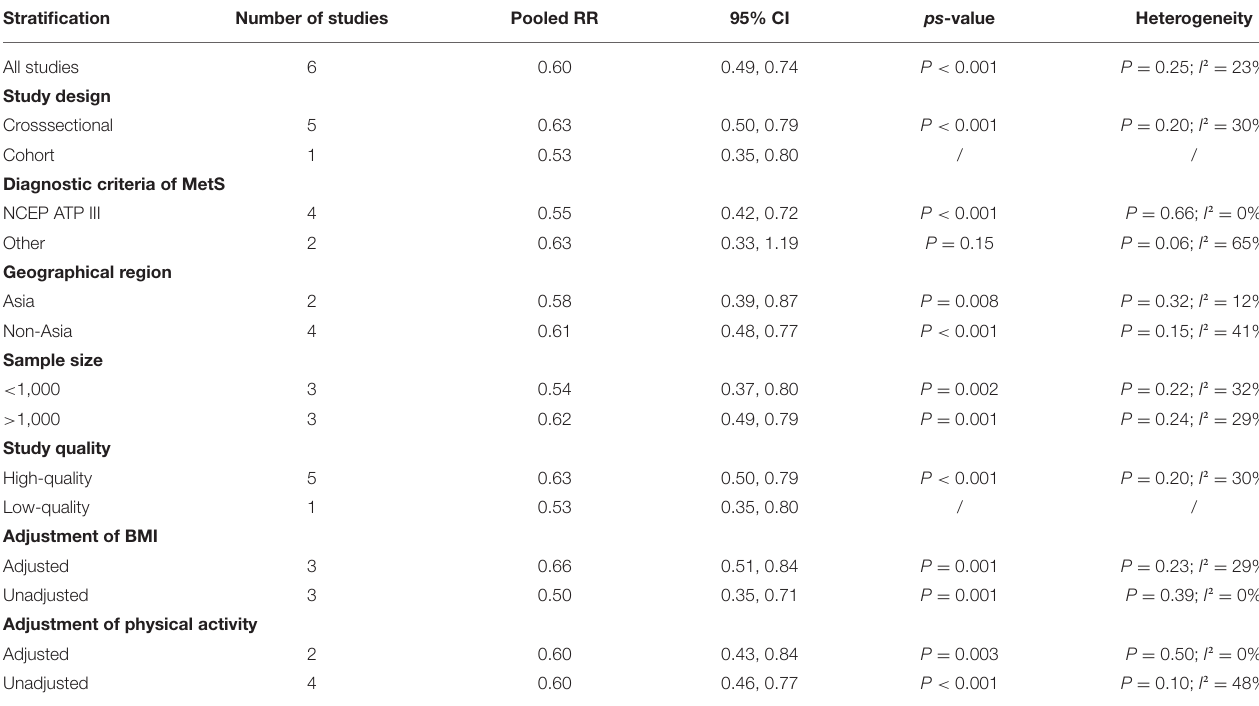
TABLE 3 | Subgroup analysis of MetS for the highest vs. lowest circulating vitamin C level